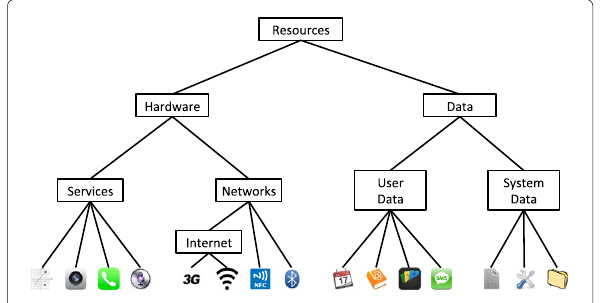
Fig. 3 Hierarchy of criteria for class Resources